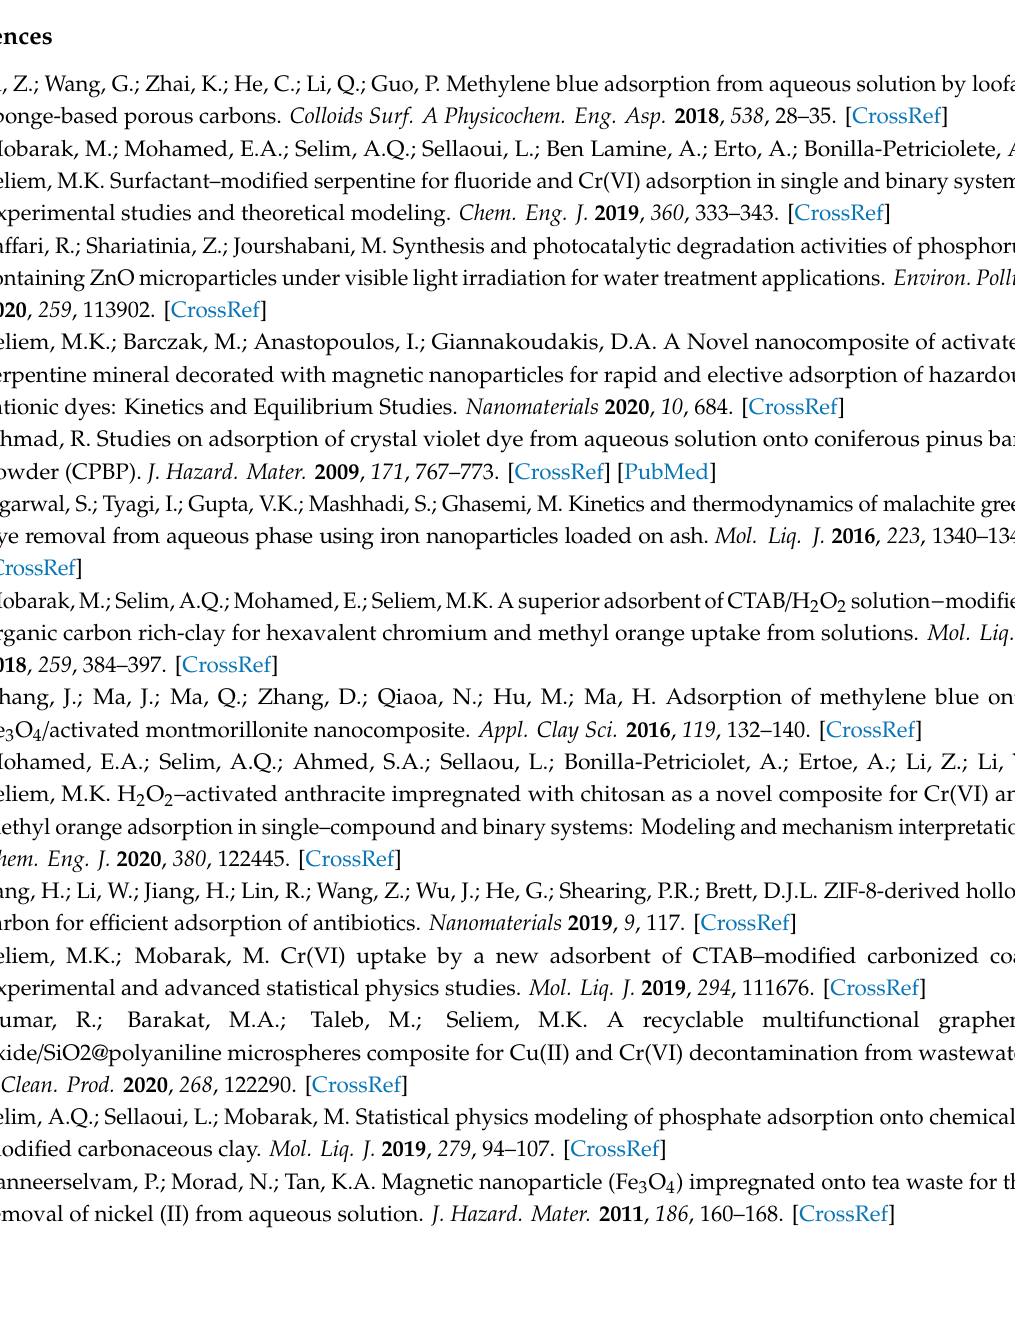
Figure S1: Linear forms of the Pseudo-first order model ( a ) and the Pseudo-second order model ( b ) for CV uptake by MNP / CTAB-EC composite at di ff erent temperatures, Figure S2: Linear Langmuir, Freundlich, and D–R isotherms models for CV uptake by MNP / CTAB-EC composite at di ff erent temperatures, Table S1: Kinetic and isotherm linear models for CV uptake by MNP / CTAB-EC composite., Table S2: Parameters of linear of kinetic and isotherm models for the adsorption of CV onto MNP / CTAB-EC